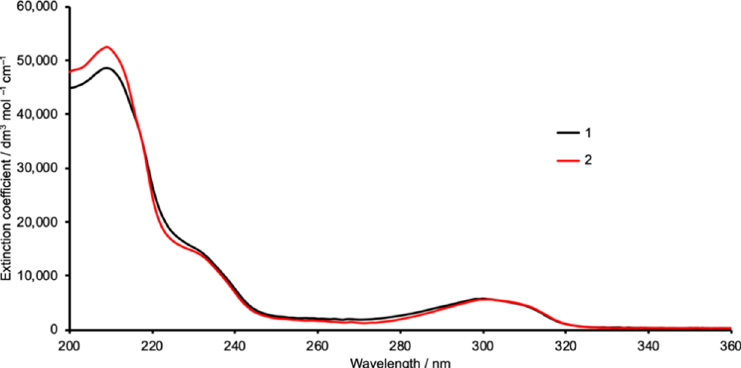
Figure 1. Solution absorption spectra of compounds 1 and 2 (MeCN, 2.0 × 10 −5 mol dm −3 ).